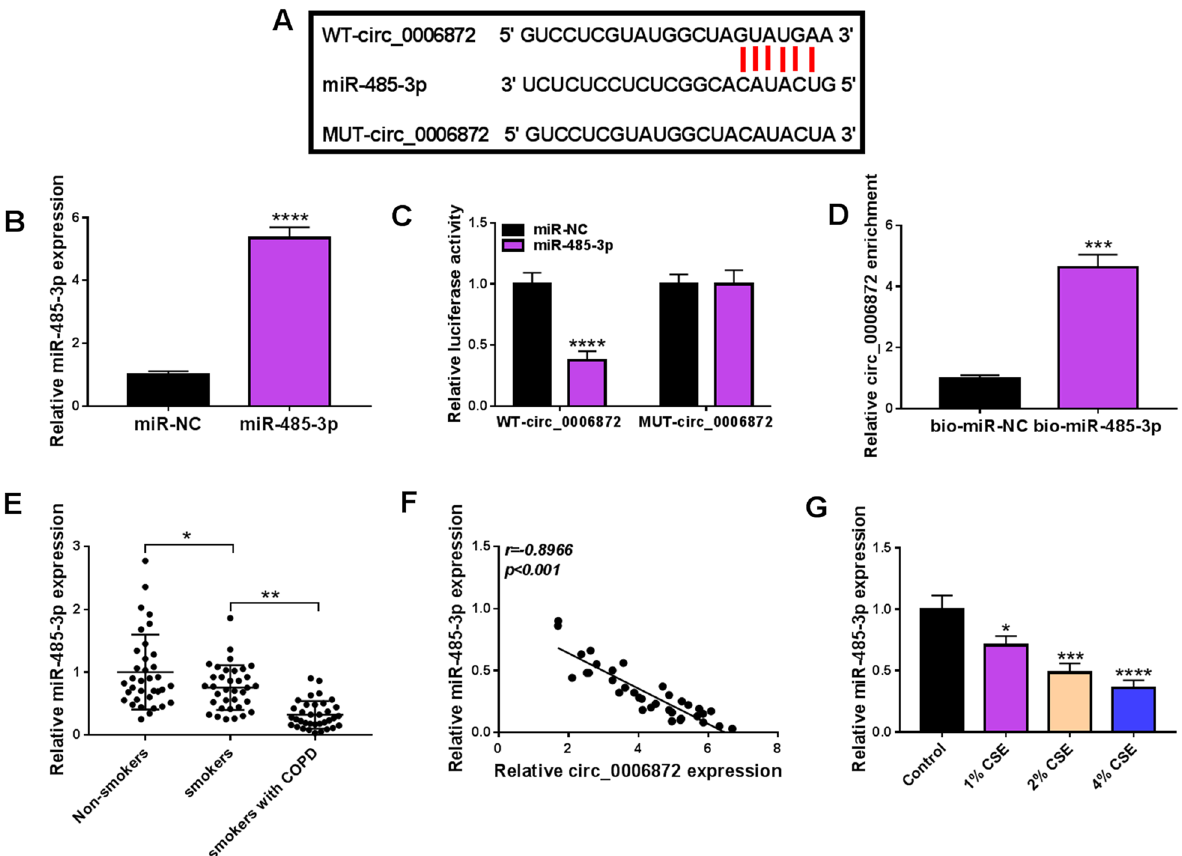
Fig. 3 Circ_0006872 acts as a sponge for miR-485-3p. A The binding site of miR-485-3p on circ_0006872 predicted by circinteractome database was listed. B The transfection efficiency detection. C , D The interaction between miR-485-3p and circ_0006872 was confirmed using dual-luciferase reporter assay and RNA pull-down assay. E The expression level of miR-485-3p was detected using qRT-PCR in non-smokers (n (n 35), and smokers with COPD (n 35). F The correlation between miR-485-3p and circ_0006872 expression level in smokers with COPD (n = = was analyzed by Pearson’s correlation coefficient assay (r -0.8966, P < 0.001). G Levels of miR-485-3p in16HBECs exposed to different concentrations = of CSE. * P < 0.05, ** P < 0.01, *** P < 0.001, **** P <